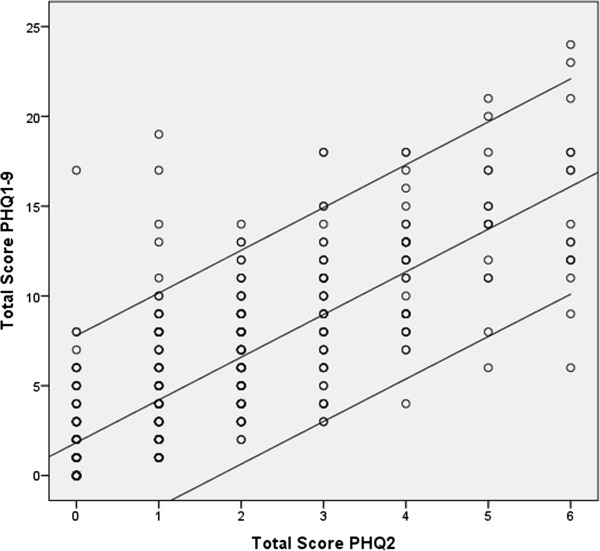
Correlation between PHQ-2 & PHQ-9 scores. R = 0.79, R2 = 0.62, F Statistic = 780.5, p-value <0.001. Regression equation: PHQ-9 = 1.83 + 2.37 x PHQ-2.